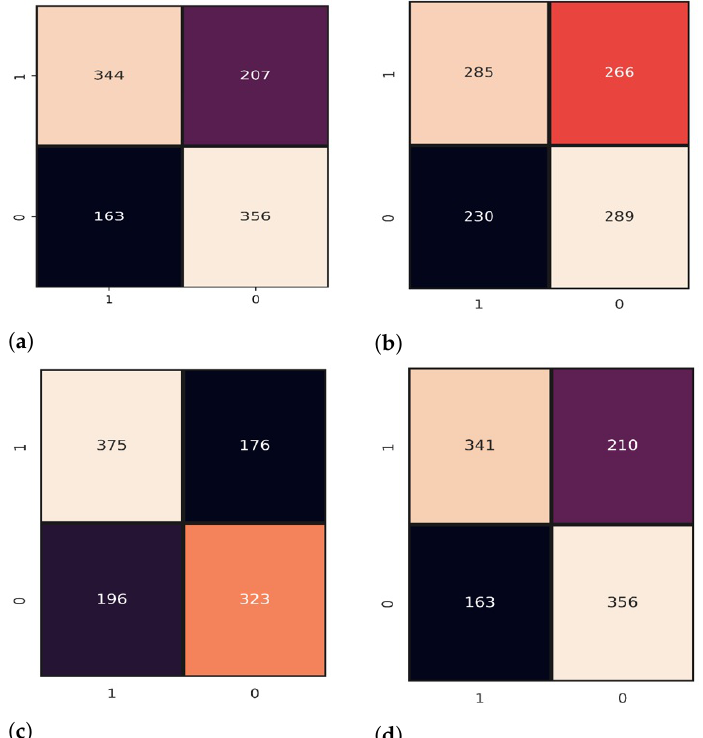
Figure 9. Confusion matrices for deep learning models, ( a ) long short-term memory model, ( b ) fully connected network, ( c ) convolutional neural network, and ( d ) gated recurrent unit.